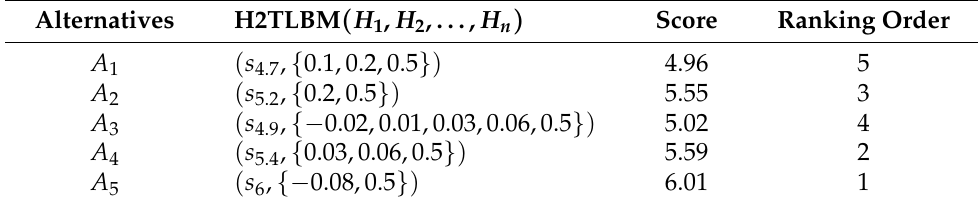
Table 6. Ranking of alternatives by using H2TLBM operator when p = q = 1.